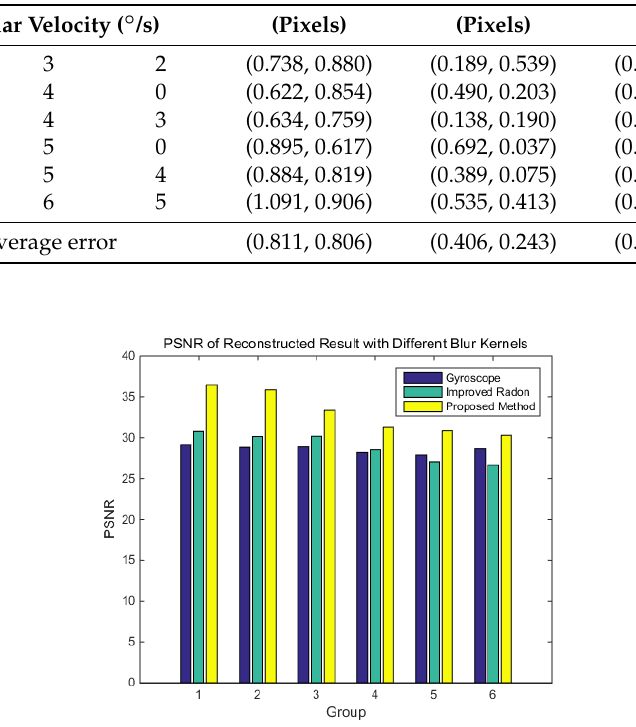
Figure 15. PSNR result after reconstruction by different blur kernels.